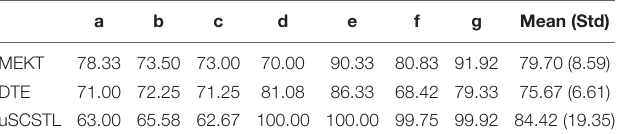
TABLE 6 | Average classification accuracies of unsupervised algorithms for all subjects on dataset MI2 ( R u =